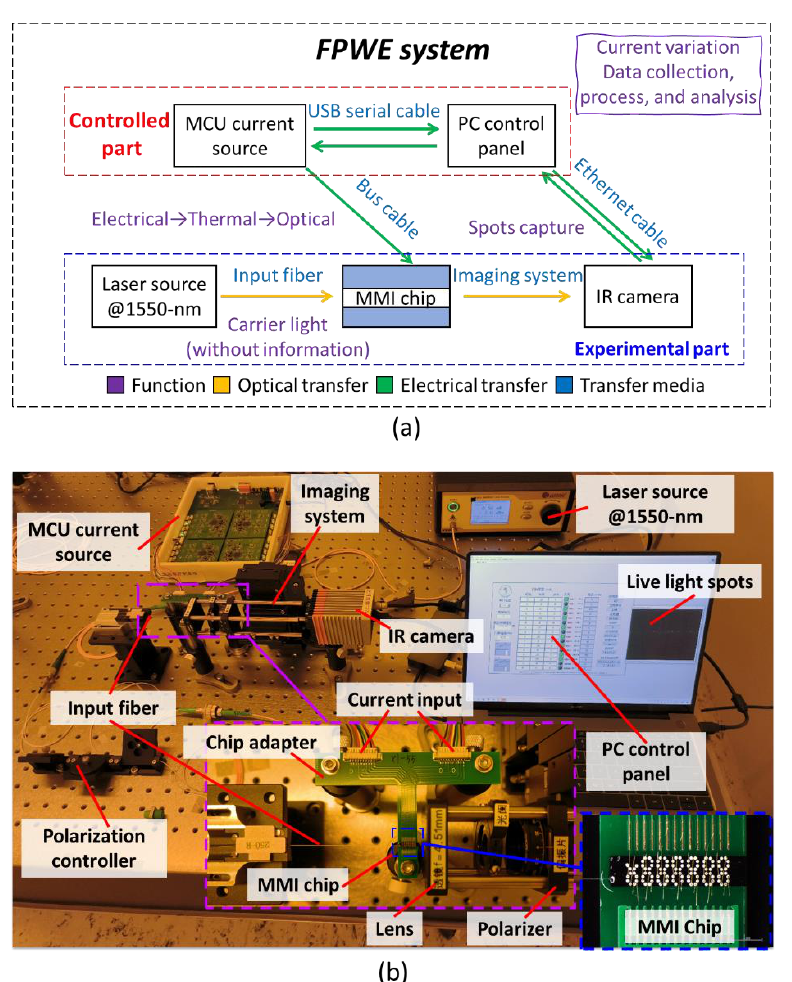
Figure 3. ( a ) Diagram and ( b ) actual photo of the FPWE